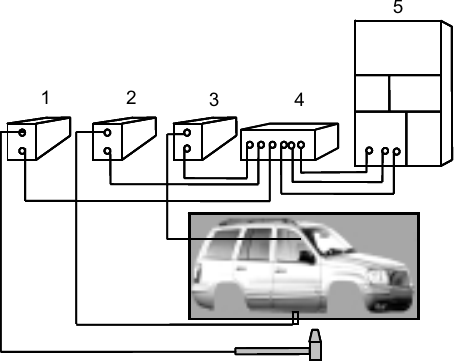
Fig. 5. Test setup for body FRF measurement. 1 – signal generator; 2 and 3 – signal conditioning; 4 – antialiasing; 5 – FFT.